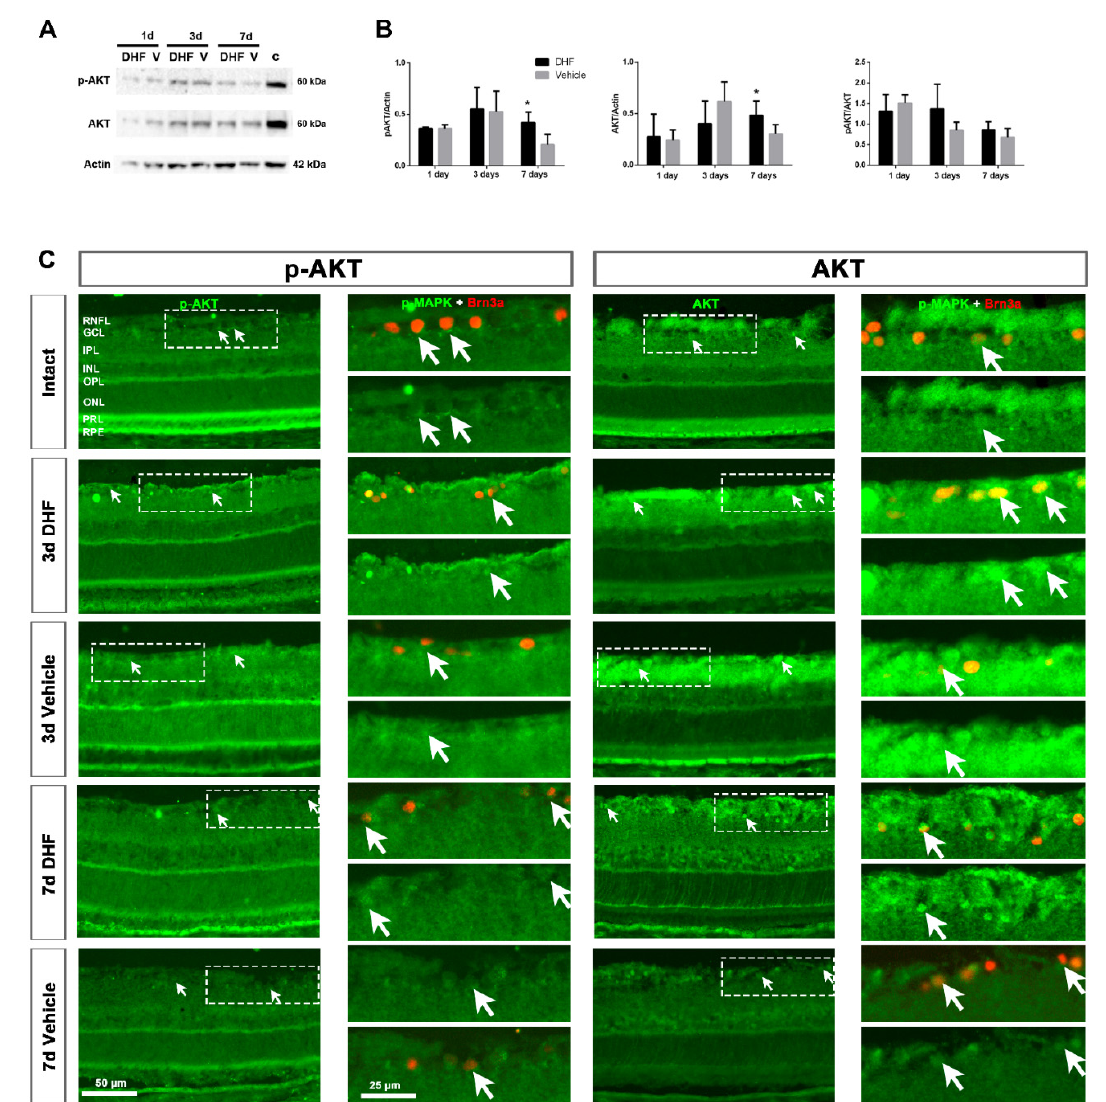
Figure 3. AKT signaling pathway. Representative images of Western blot ( A ) from AKT protein level in retinal samples (pool of four samples/time-point). Western blot was performed with retinal extracts from intact (c) and left injured retinas daily treated with DHF or vehicle (V) analyzed at 1, 3 or 7d after IONT. ( B ): Bar graphs of the quantitative analysis of phosphorylated ( p -) AKT and the total protein AKT compared to actin protein level, and normalized p-AKT/AKT. In all graphs, results are presented as mean ± SD relative to intact retinas (considered 1.0). Kruskal–Wallis test, * p < 0.05). ( C ): Representative cross-sectioned retinas (20×) of phosphorylated AKT (left) and total AKT (right) signal in intact and axotomized retinas treated with DHF or vehicle at 3 and 7 days after IONT. In the right column of each one, a magnification of double immunostaining with Brn3a (upper part) and p-AKT or AKT alone (lower part) is shown, pointing the co- expression (arrows) and no co-expression (arrowheads) between them. RNFL = retinal nerve fiber layer, GCL = ganglion cell layer, IPL = inner plexiform layer, INL = inner nuclear layer, OPL = outer plexiform layer, ONL = outer nuclear layer, PRL = photoreceptor layer, RPE = retinal pigment epithelium, d = days post-lesion. Scale bar is shown at the bottom left.